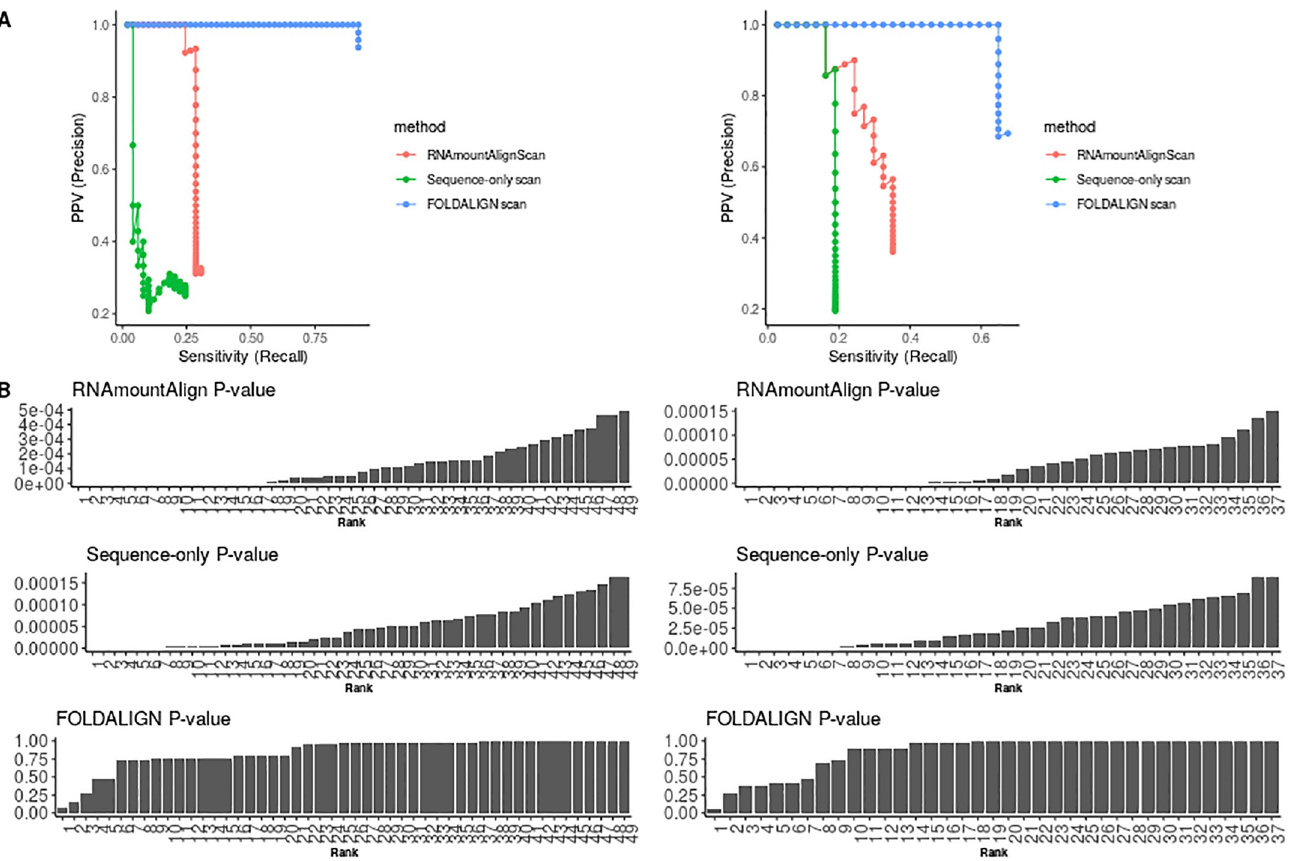
Fig 9. ( A ) PPV-sensitivity (precision-recall) plot for tRNA query scan in E. coli genome. Measures are computed for the top 49 and 37 tRNA predictions in forward ( left ) and reverse ( right ) strands of E. coli genome, respectively. Since RSEARCH had no true positives and thus zero sensitivity and PPV, it is not shown here. (B) The predicted p -values of the top predictions for each software in forward ( left ) and reverse ( right )